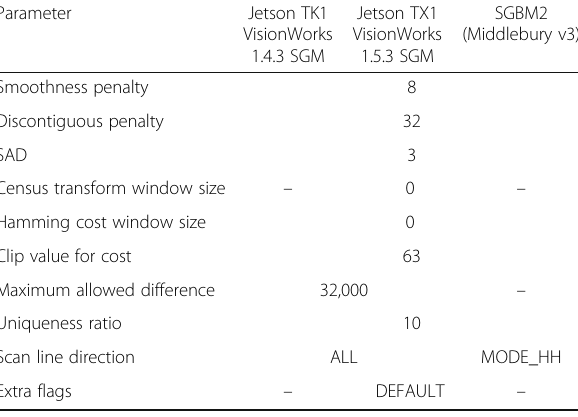
Table 3 SGM parameters for different VisionWorks versions, side by side with the SGBM parameters that are presented in the Middlebury evaluation table Parameter